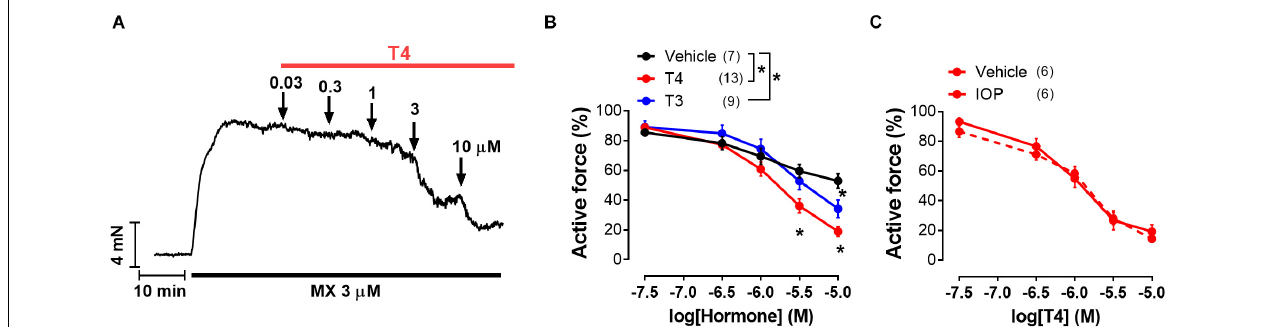
FIGURE 1 | T4 induces more pronounced vasorelaxation of rat sural arteries than T3. (A) Original recording of the T4-induced concentration-dependent vasodilation of the sural artery precontracted by the α 1 -adrenoceptor agonist methoxamine (MX). (B) Concentration-response relationships to thyroid hormones of the methoxamine-precontracted sural arteries. (C) Concentration-response relationships to T4 of sural arteries precontracted by methoxamine in the presence of 5 (cid:48) -deiodinase inhibitor iopanoic acid (IOP, 100 µ M) or its vehicle. For panels (B,C) average active force value for 10-min interval before addition of the first hormone concentration was taken as 100%. Number in parentheses represents the number of animals. * p < 0.05 compared to vehicle group (Repeated Measures ANOVA with Tukey’s post hoc test).